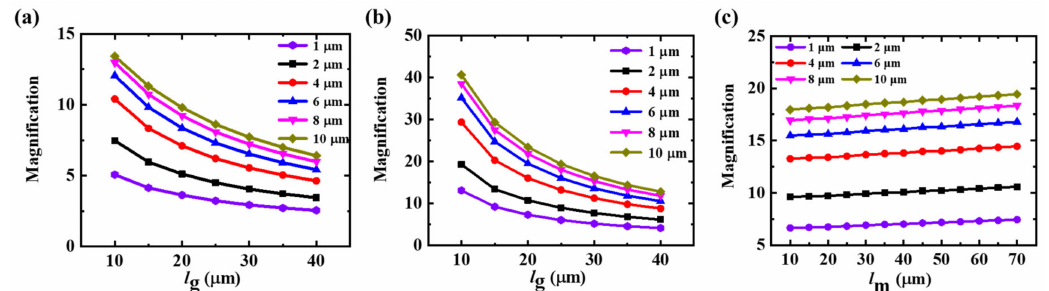
Figure 2. The magnification as a function of gap width with di ff erent concentrator thicknesses for ( a ) single-gap MFC, ( b ) double-gap MFC, and ( c ) the magnification as a function of magnetic stripe width under di ff erent concentrator thicknesses for double-gap MFC.